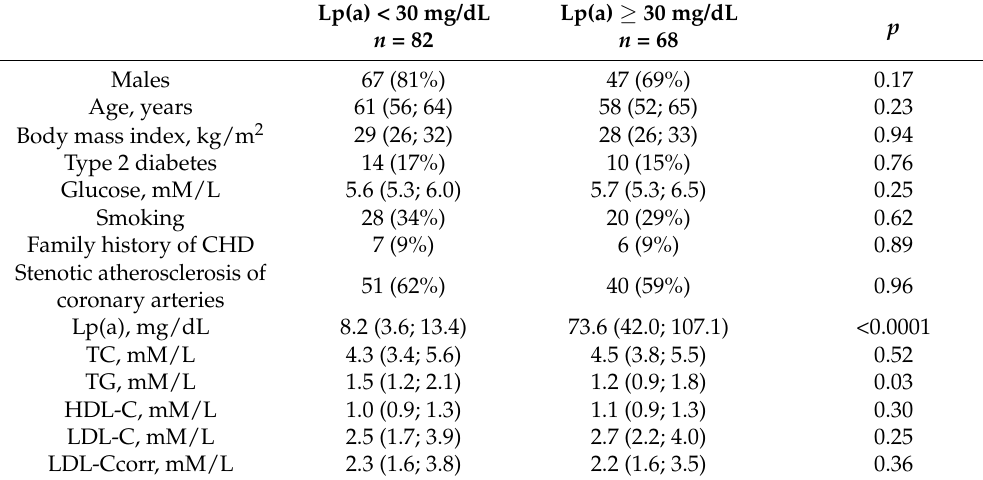
Table 1. Characteristics of the study patients.